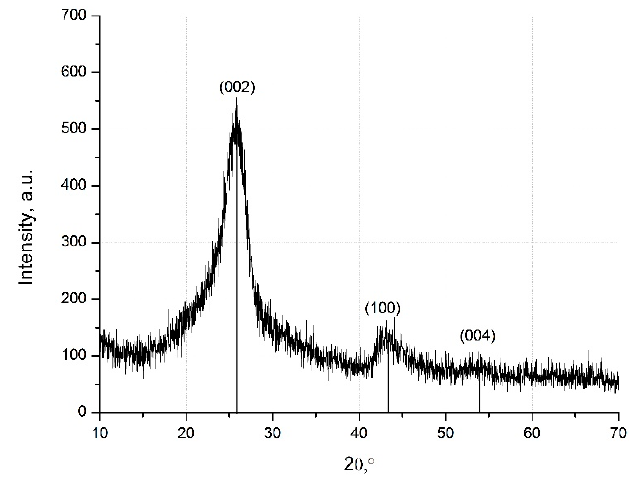
Figure 2. X-ray spectra of the MW-CNTs.